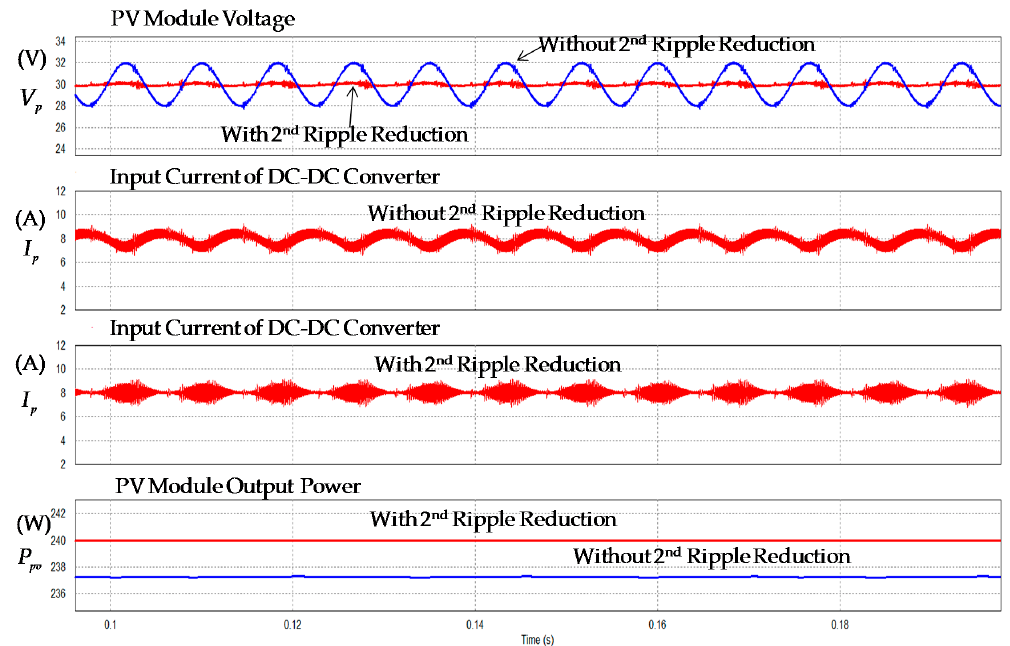
Figure 8. Voltage regulation response of PV module without and with proposed 2nd ripple voltage reduction control at input.